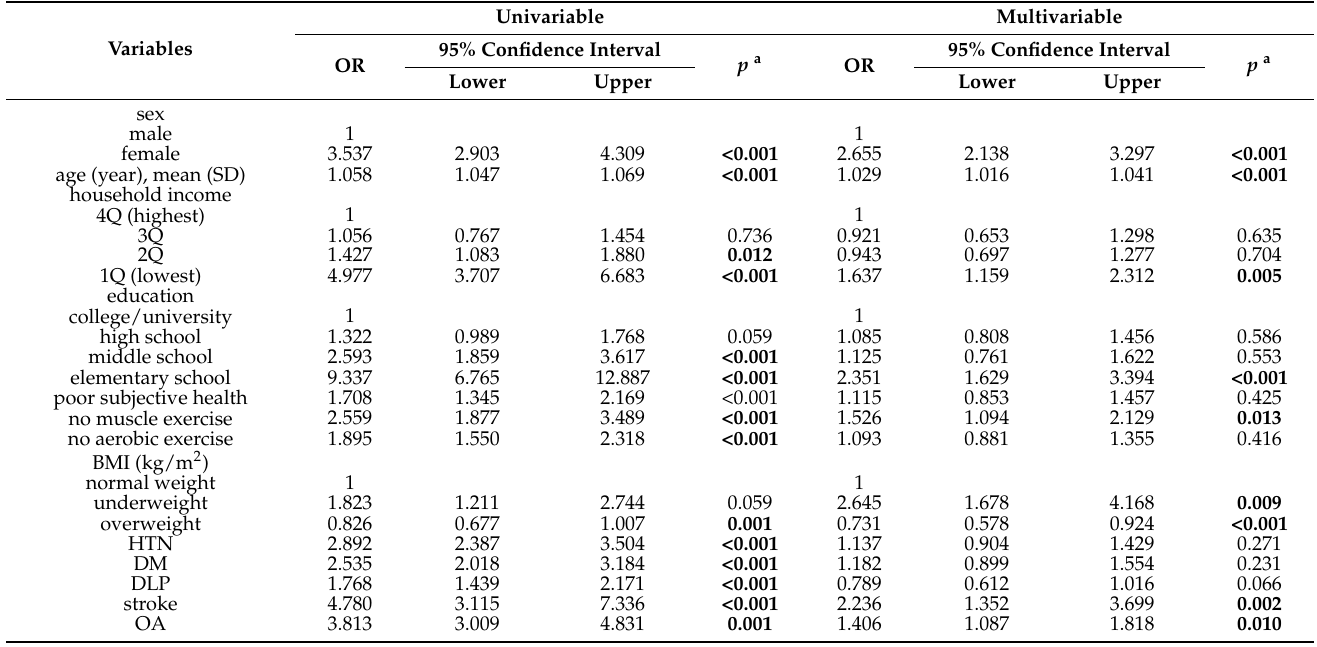
Table 2. Univariable and multivariable logistic regression models: odds ratios for poor